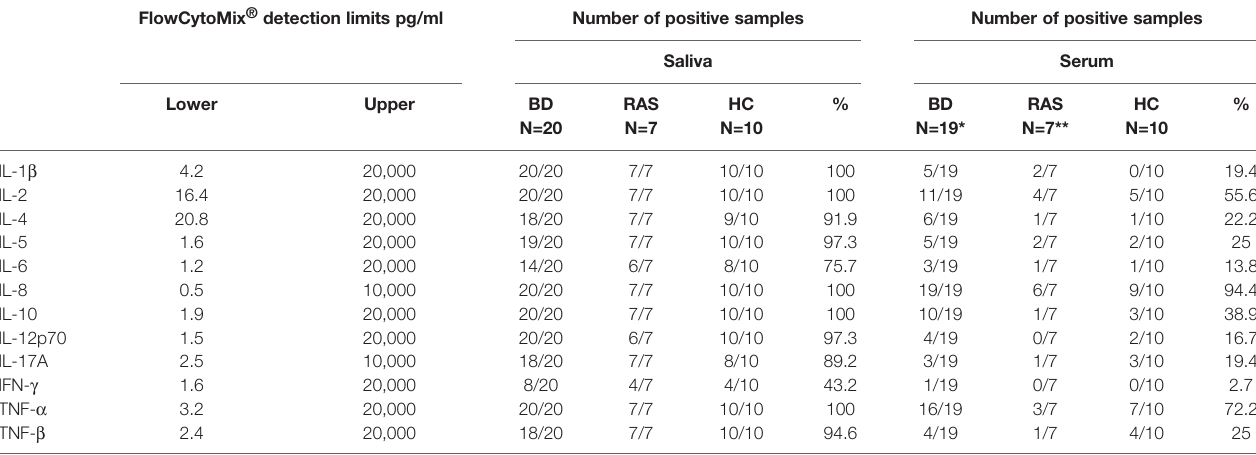
TABLE 2 | Number of samples with detectable cytokine levels in BD, RAS and HC matched saliva and serum as measured by the FlowCytomix assay. FlowCytoMix ® detection limits